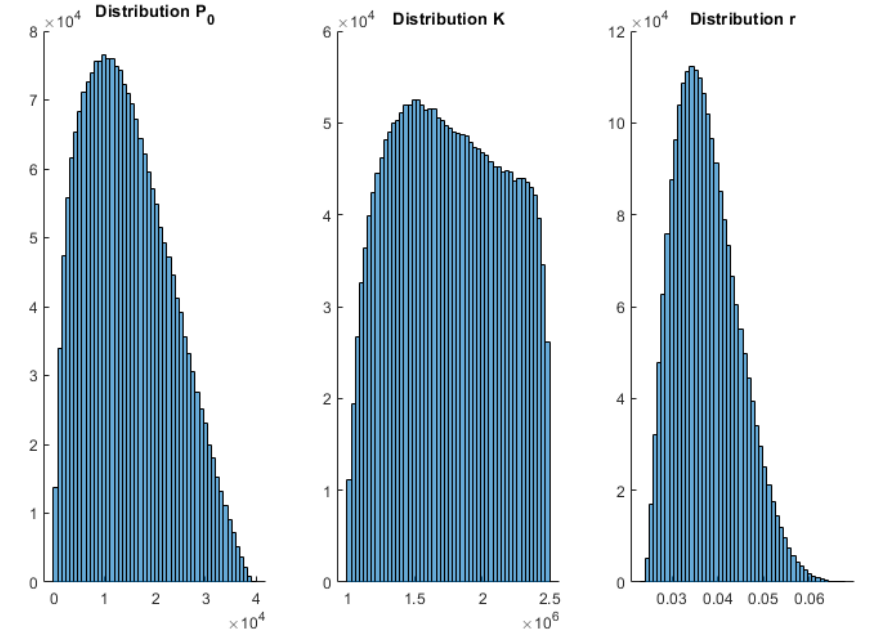
Figure A5. Histograms 25 January 2021 wave 3 Gompertz — Spain.